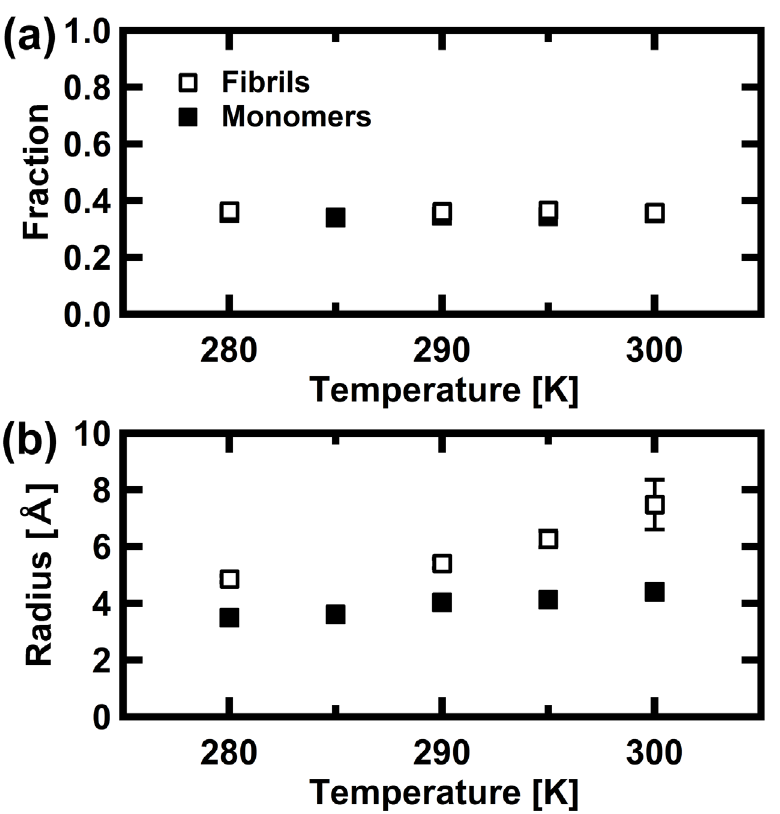
Fig 5. Summary of parameters estimated from the fits to the EISF curves. The parameters calculated using Eq 2, shown in Fig 4 are shown. The parameters shown are (a) the fraction of frozen atoms ( p in Eq 2), and (b) the radius of the confined sphere ( a in Eq